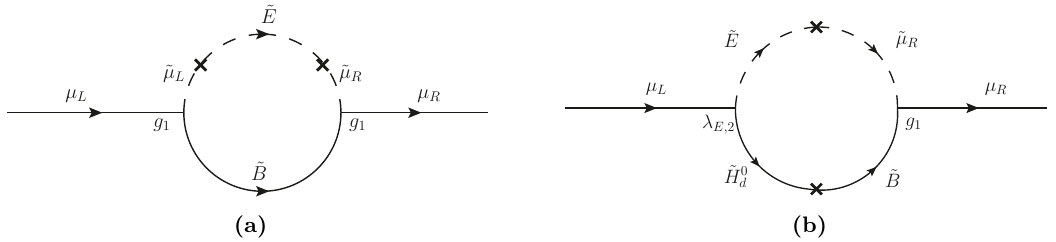
2) in the QUE model. The photon line attached (cid:22) (cid:0)